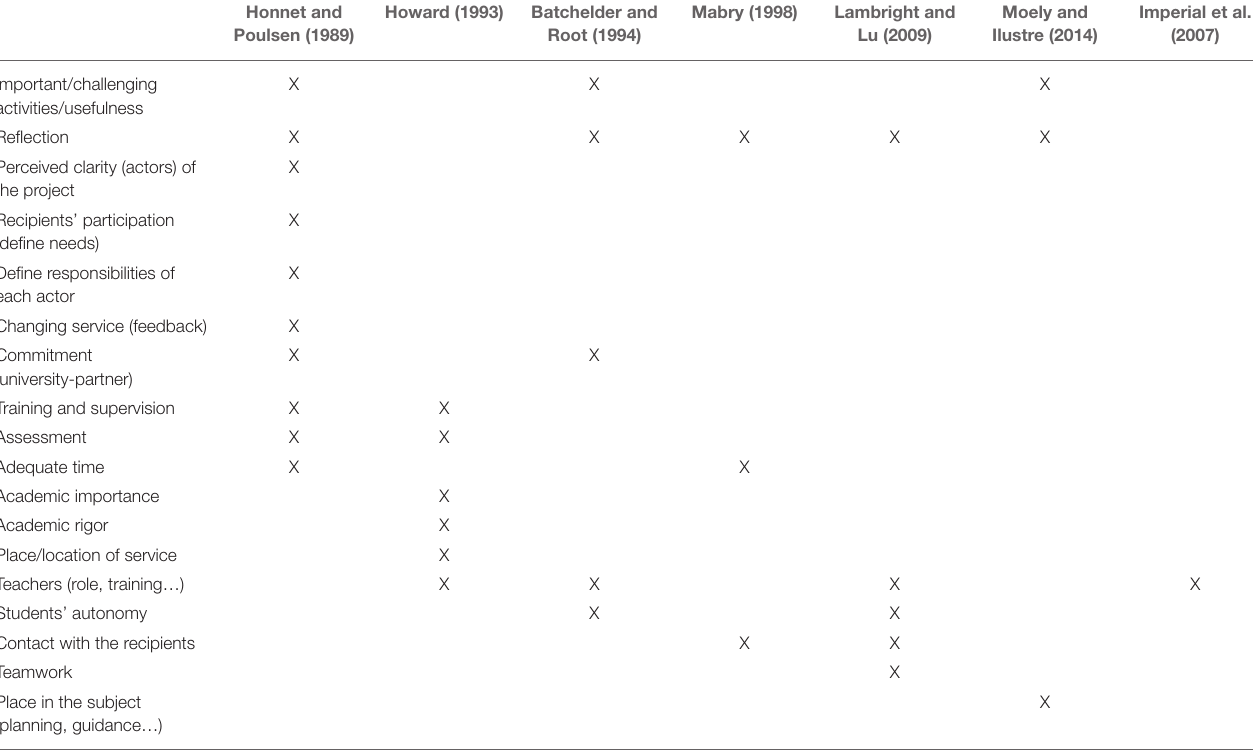
TABLE 1 | Quality criteria for SL